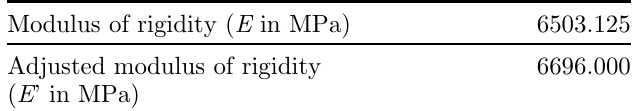
Table 2. The results of the